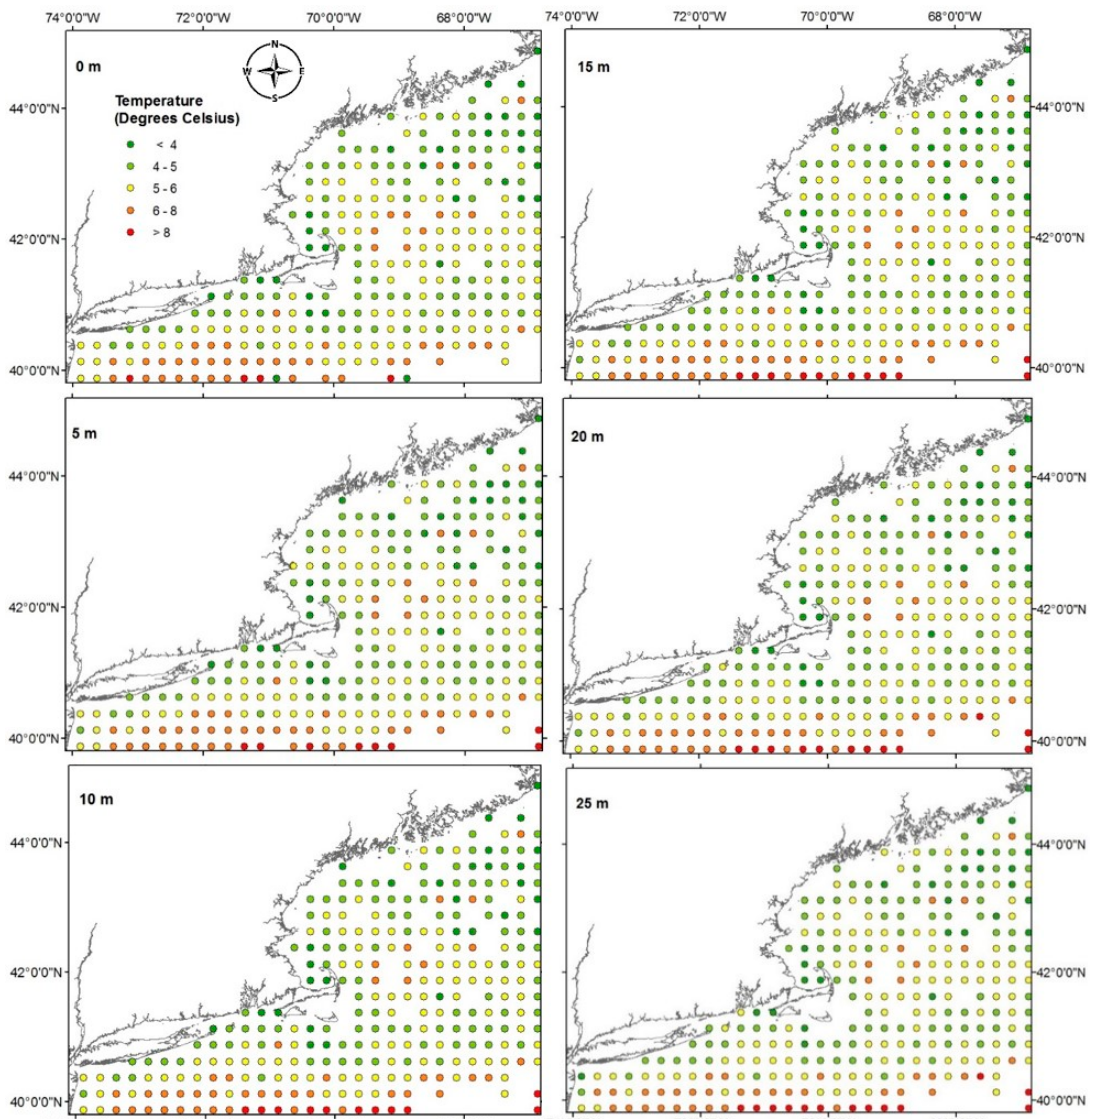
Figure 7. Depth distribution of temperatures shown as averaged means of the years 2005 to 2012 in winter.